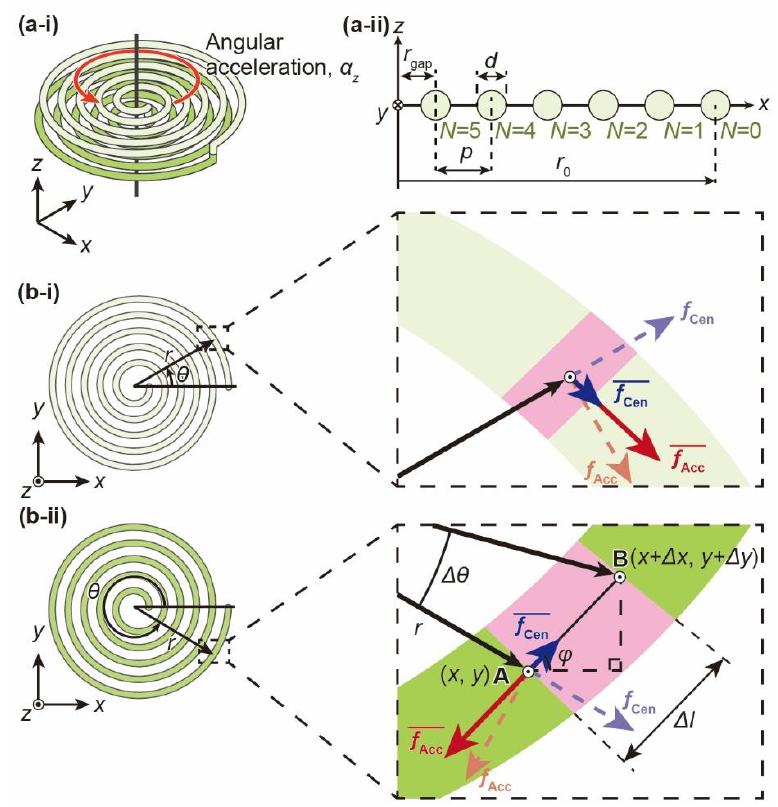
Figure 2. Illustration of the force applied to the fluid in the spiral channel. The dotted arrow shows the inertial force, f Acc , caused by the angular acceleration, and the centrifugal force, f Cen . The solid arrow shows the component force of the inertial force, 𝑓 Acc ̅̅̅̅̅ , and the centrifugal force, 𝑓 Cen ̅̅̅̅̅ in the tangential direction to the channel. ( a-i ) Bird-eye view schematic image of the spiral channel and ( a-ii ) cross-sectional view and parameters of the upper spiral channel. The parameters are defined as follows: the number of turns, N , the outer radius, r 0 , the distance from the origin to the end of the spiral, r gap , the diameter of the channel, d , and the pitch of the spirals, p . ( b-i ) The upper spiral and an enlarged view and ( b-ii ) the lower spiral and an enlarged view.